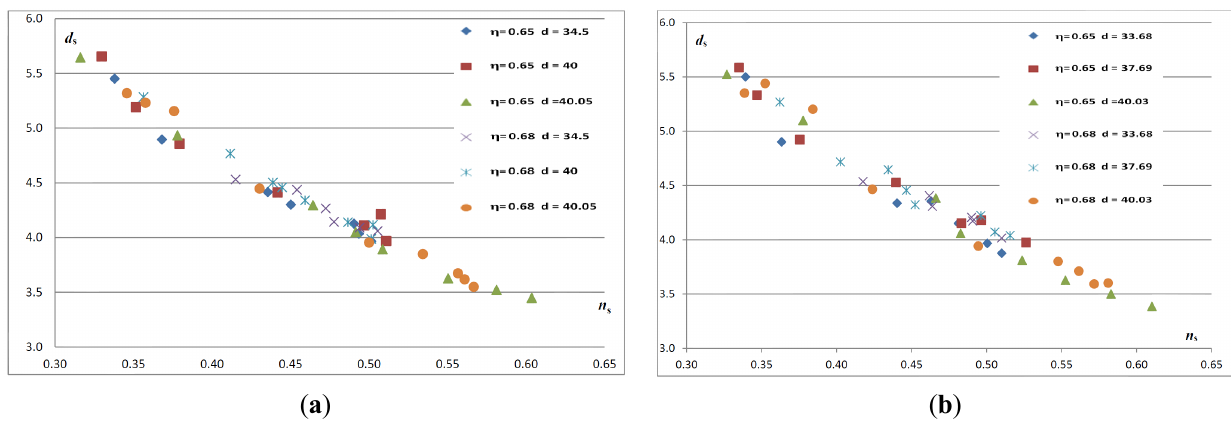
Figure 8. The low-Re Cordier curve on the standard Balje compressor map. Comparison between the actual Cordier line and the Modified Cordier line.